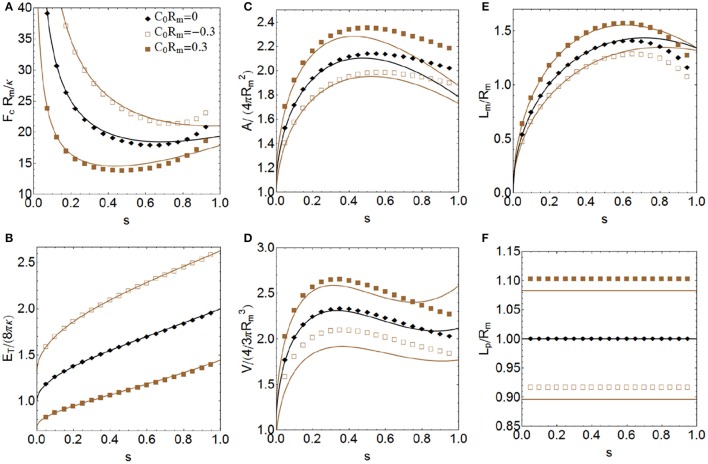
More relevant properties of a constricted vesicle at all stages of constriction for Σ = Δp = 0 and three values of the product C0Rm, corresponding to have negative, zero, and positive spontaneous curvature. Total energy ET in units of 8πκ (A), constriction force Fc in units of Rm/κ (B), total area A in units of 4πRm2
(C), total volume V in units of 4/3πRm3
(D), constriction length Lm in units of Rm
(E) and polar distance Lp in units of Rm
(F). Comparison between the exact numerical results (points) with the approximate analytical expressions obtained up to sixth order of perturbation (lines).